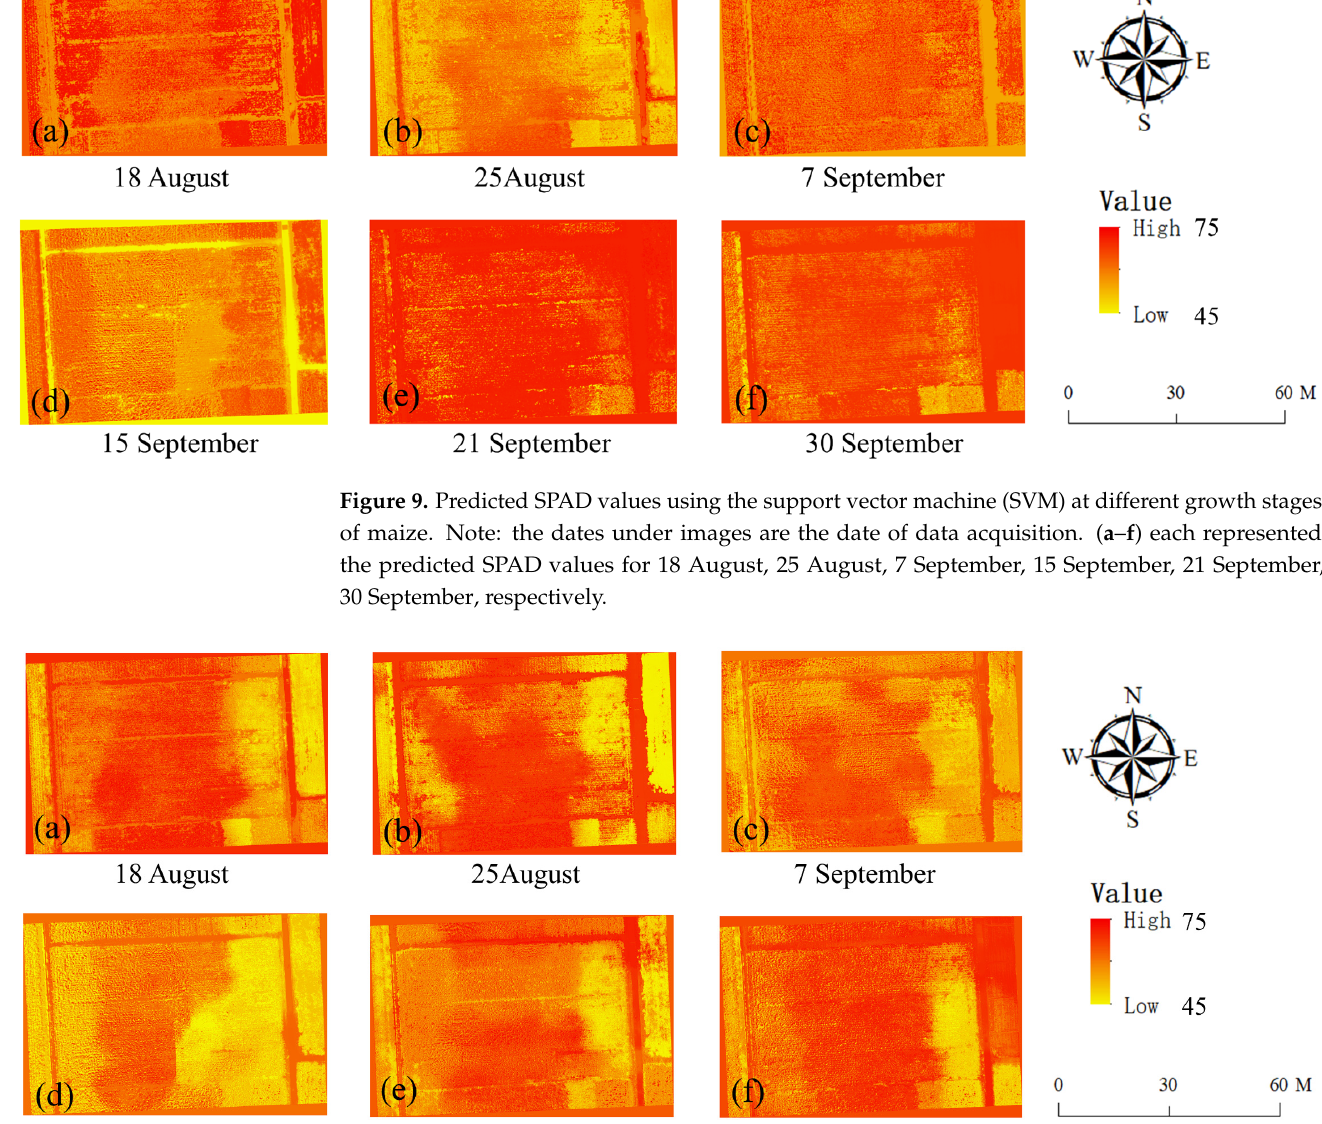
Figure 10. Predicted SPAD values using the random forest (RF) model at different growth stages of maize. Note: the dates under images are the date of data acquisition. (a)-(e) each represented the predicted SPAD values for 18 August, 25 August, 7 September, 15 September, 21 September, 30 September, respectively.